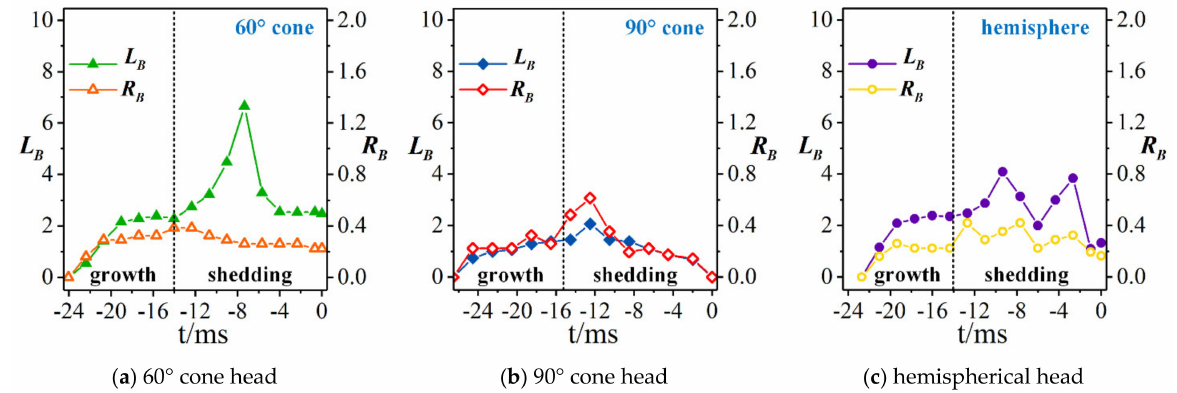
Figure 5. Variation curves of cavitation morphological parameters of three head-shaped projectiles. ( a ) 60 ◦ cone head ( b ) 90 ◦ cone head ( c ) hemispherical